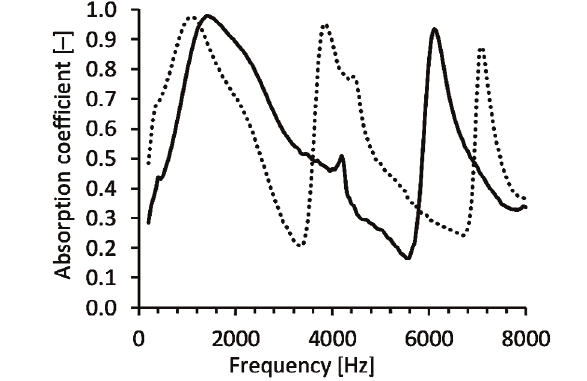
Fig. 13. Absorption coefficient for material B, distance X1 was set to 30 mm (solid line) and to 50 mm (dotted line).